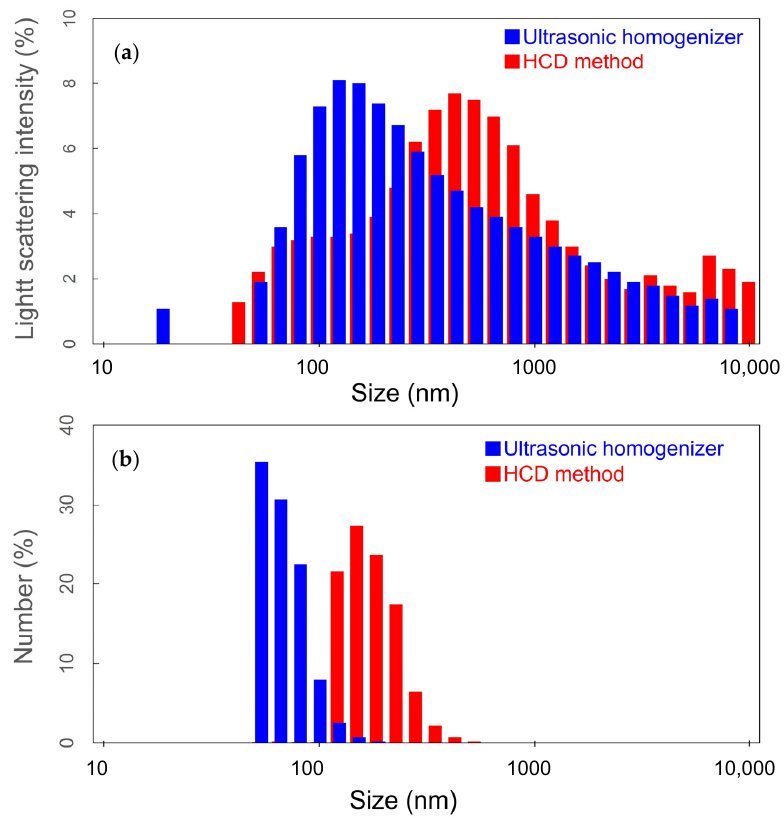
Figure 4. ( a ) Light-scattering intensity and ( b ) particle size distributions in the SWCNT dispersion prepared by ultrasonic homogenizer (blue) and HCD method(red).